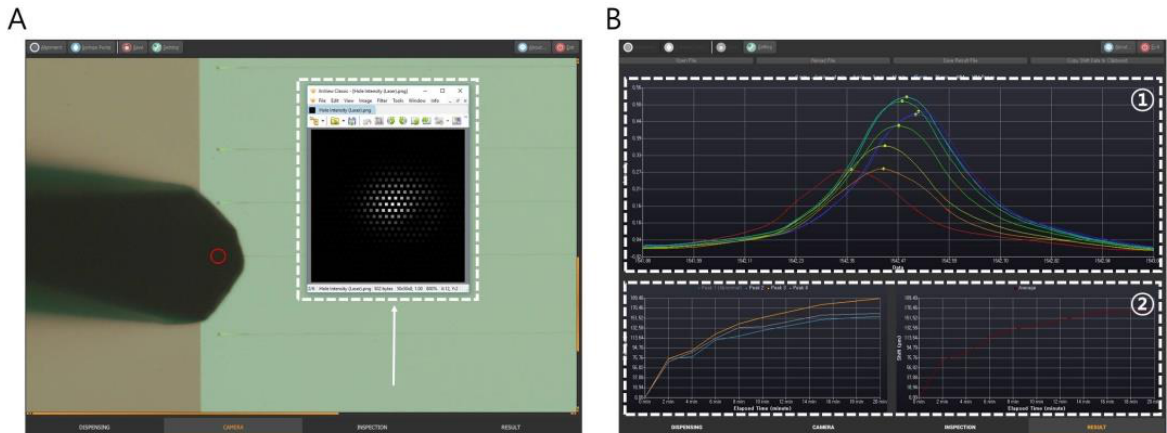
Figure 2. Illustration of the automatic optical sensing measurement system using our developed software program. ( A ) Optical alignment of the ball-lensed optical fiber (BLOF) through monitoring of the optical signal intensity. ( B ) Biosensor measurement of the shift in resonant wavelengths in a given time (0–20 min).